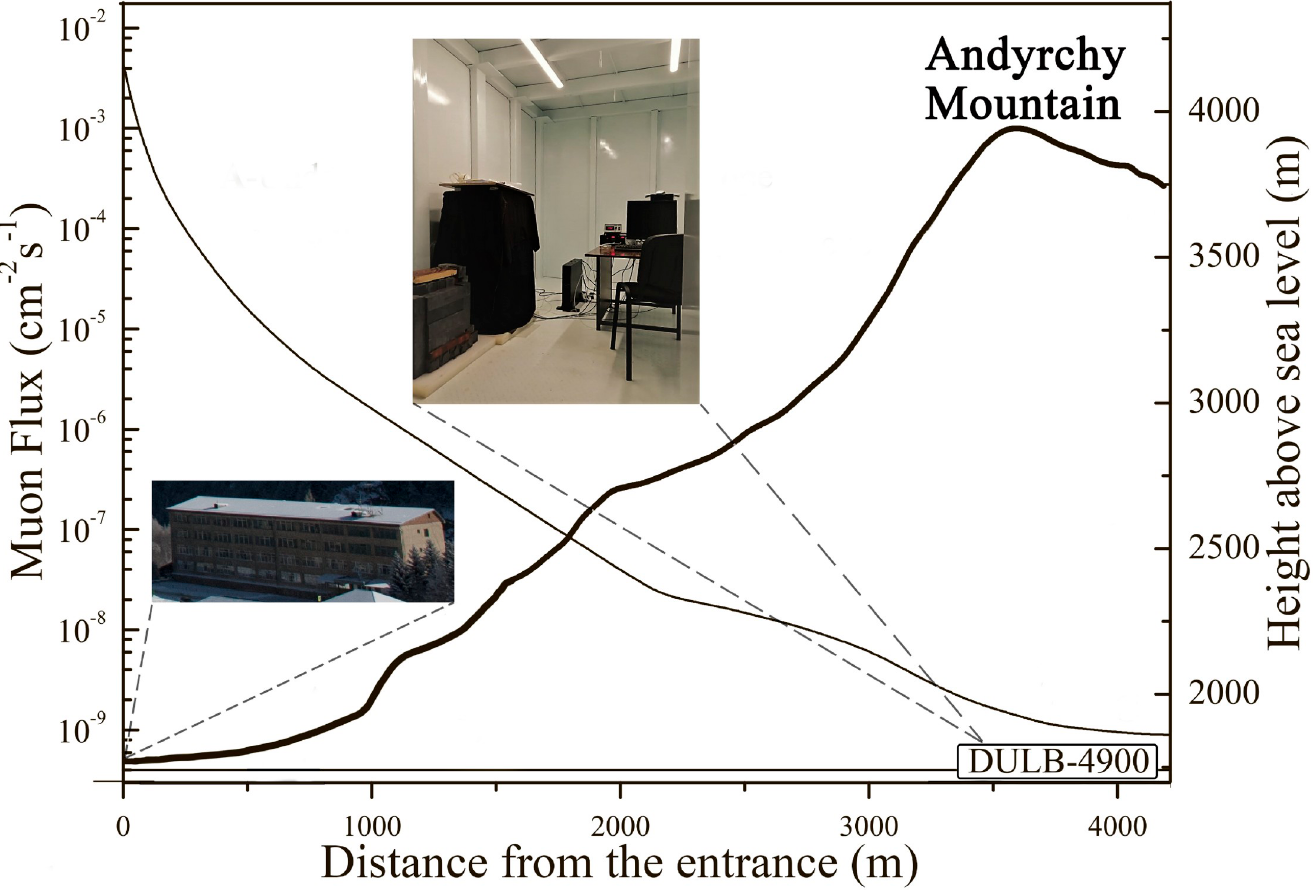
Fig 1. Locations and muon flux parameters of the BNO ground laboratory and the DULB-4900 low-background laboratory in the Andyrchy mountain (data from [32]).